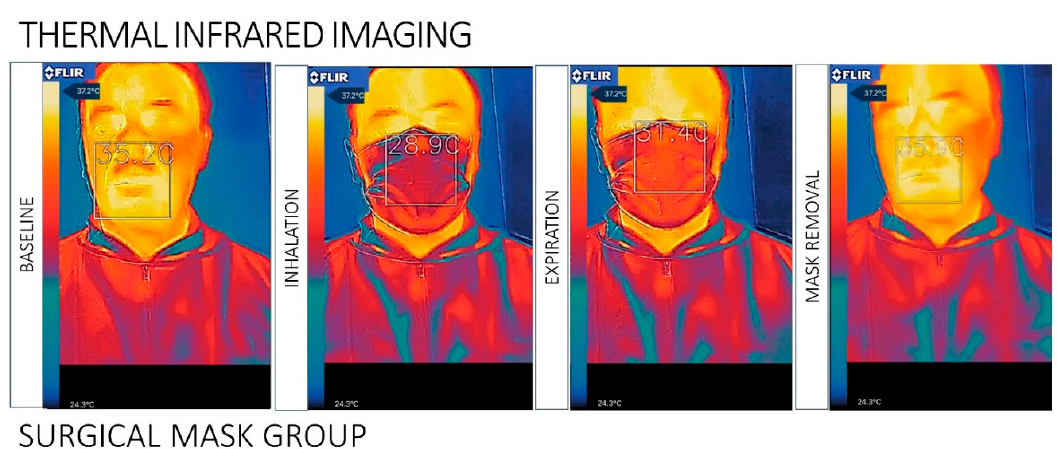
Figure 2. Surgical mask group: The infrared images of facial skin temperature distributions associated with the use of a ventilation mask in male subject prior to applying the mask, with the mask applied, and after removal of the mask. The values specified on the thermal images are the local temperatures at the sites of interest (bridge of the nose, two cheeks, and chin), averaged in the respective marked regions (bounded by ellipses). All temperature values are in Celsius.